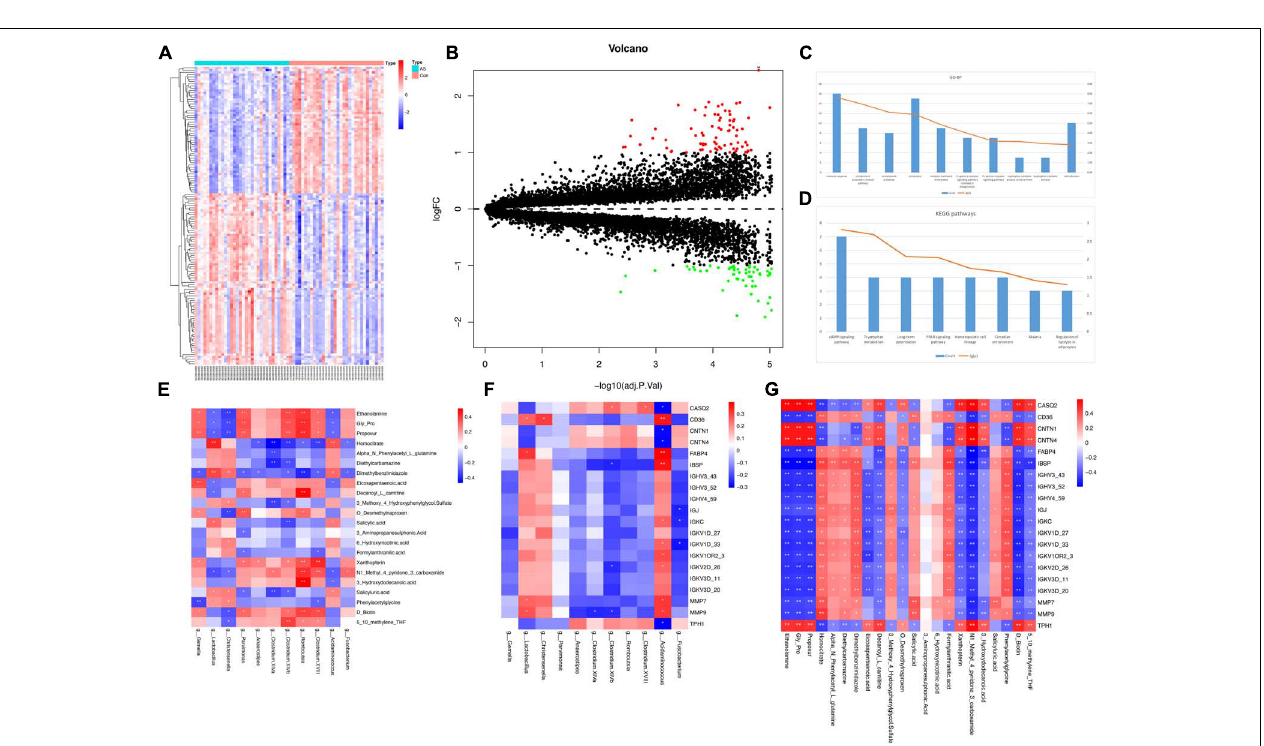
FIGURE 7 | DEG analysis and correlation between different types of omics data. (A,B) Expression patterns of DEGs were shown by heatmap and volcano plot. (C,D) GO-BP terms and KEGG pathways with top-10 count number were visualized. Functional enrichment analysis for DEGs showed that these DEGs were mainly associated with inflammatory and immune response. (E–G) Pairwise correlation between microbiome, metabolome, and transcriptome data. Reder color indicates a stronger correlation, whereas bluer color indicates a weaker